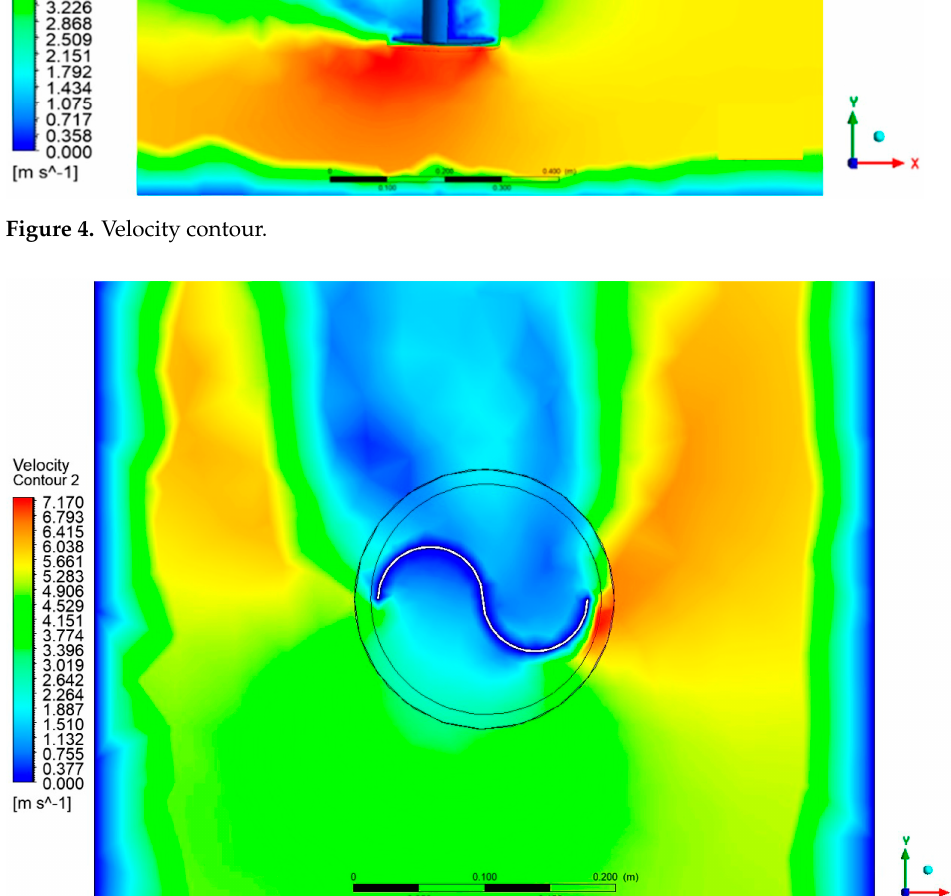
Figure 5. Maximum speed reached by the laminar flow in contact with the Savonius rotor.